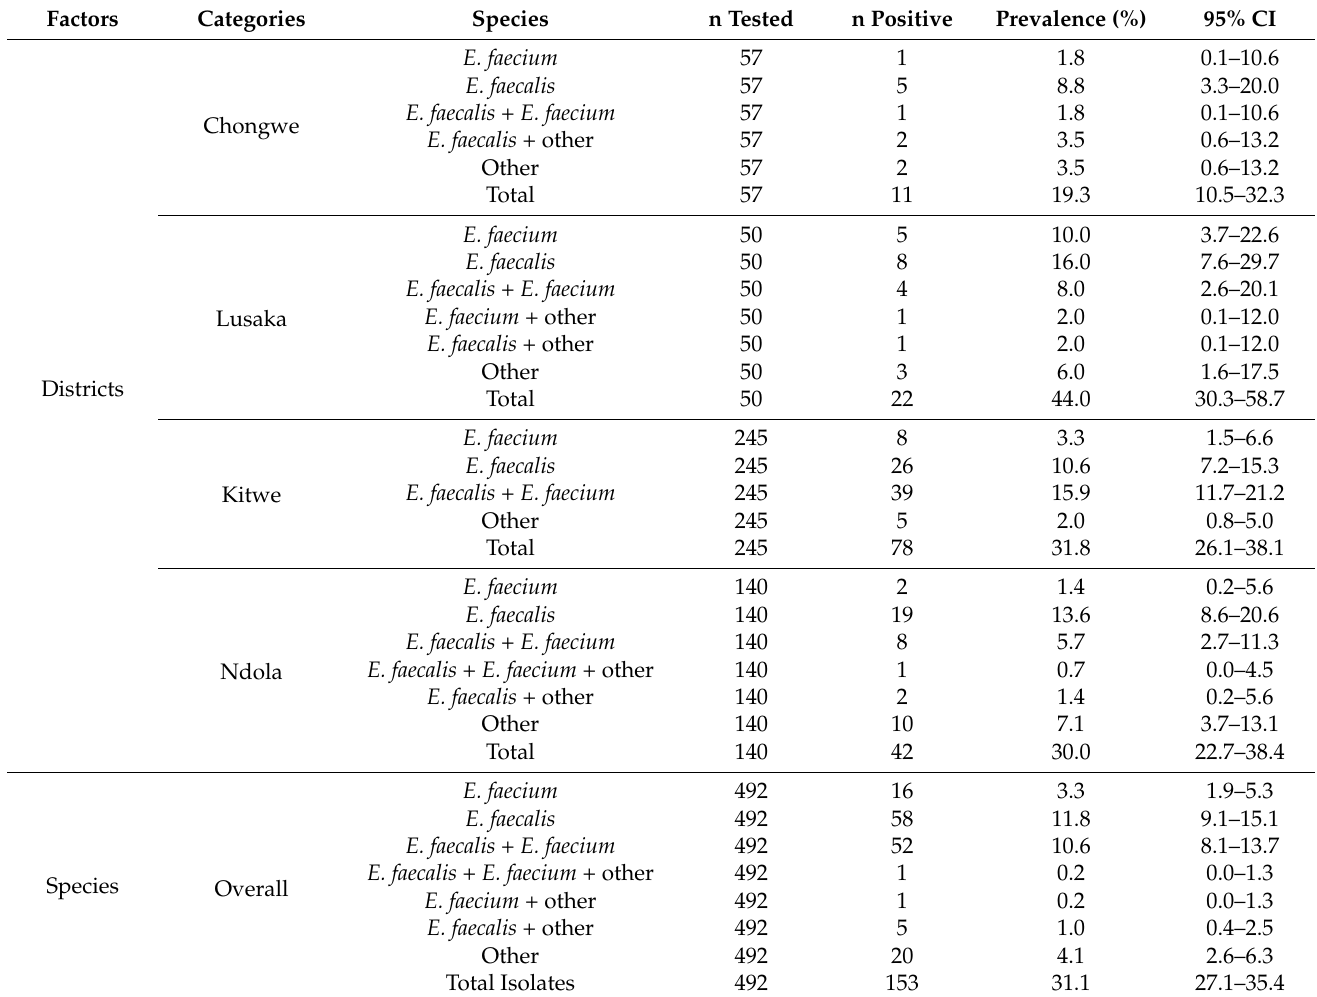
Table 3. Prevalence of specific species across the study